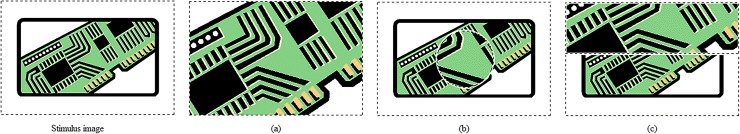
An illustration of stimulus images for different magnification modes.(A) full screen, (B) circular, and (C) fixed-area.